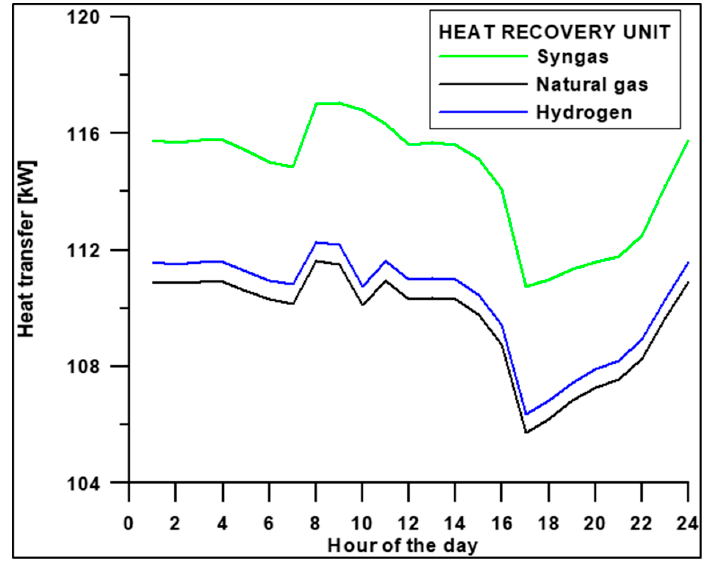
Figure 11. Heat transfer in heat recovery unit in a day.